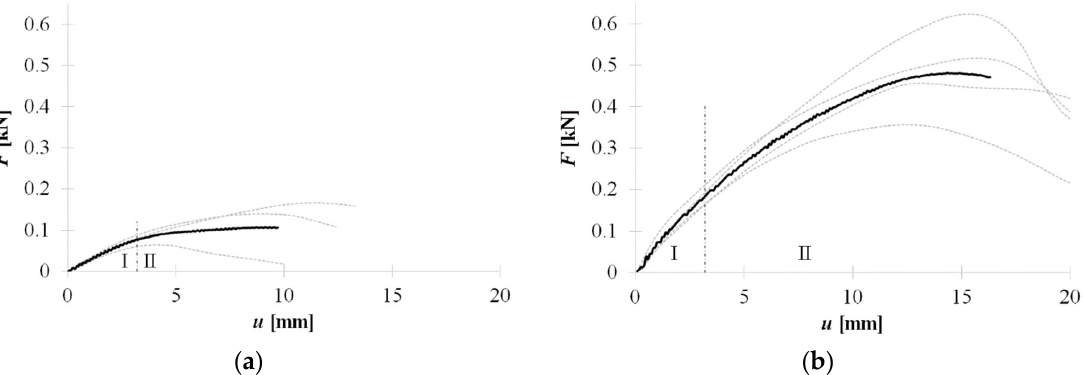
Figure 15. Equilibrium load ‐ displacement paths of non ‐ penetrating connectors: ( a ) pointwise tape (TP), ( b ) continuous tape (TL).